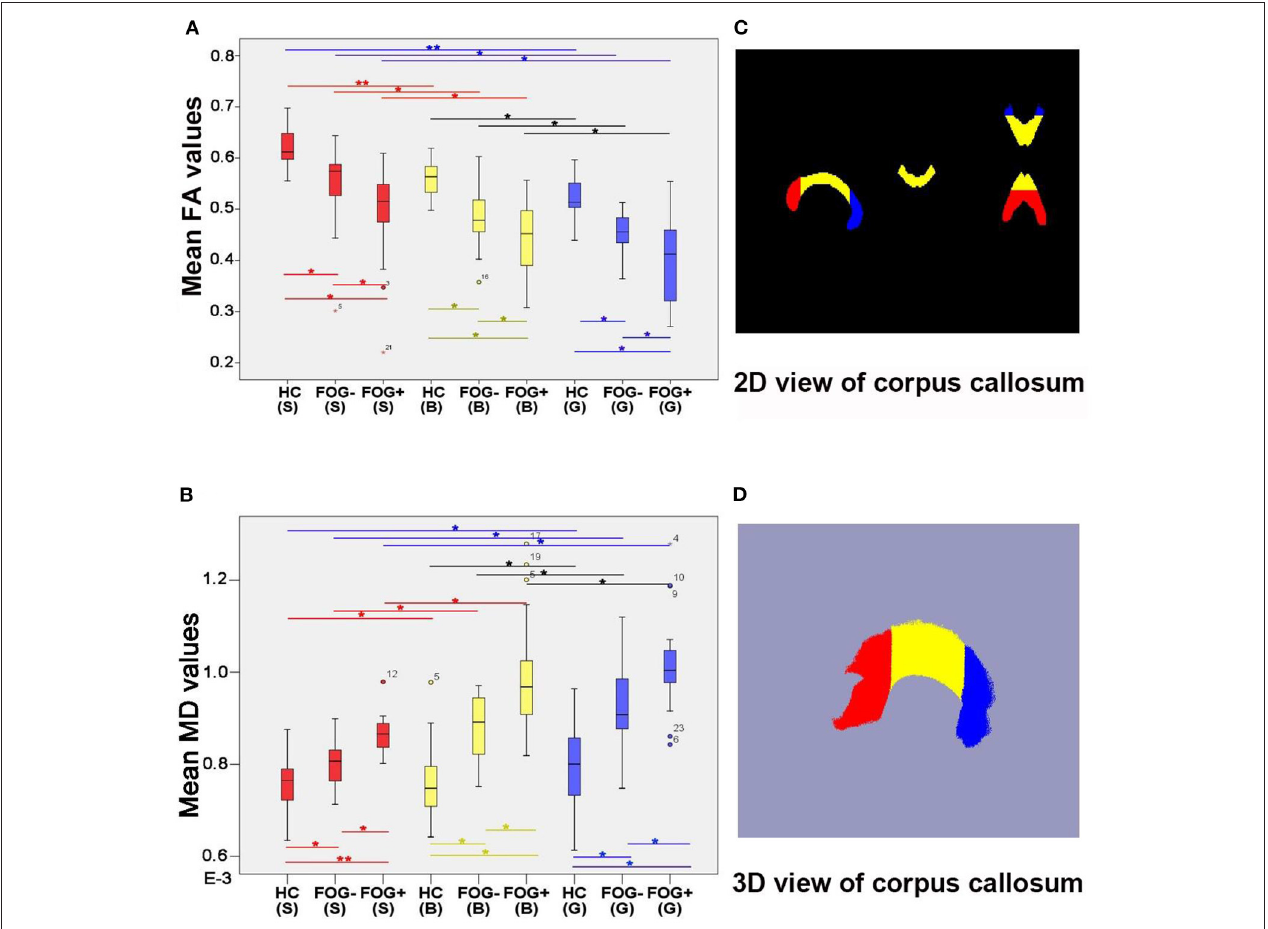
FIGURE 3 | Comparison of FA and MD values of CC splenium, body, and genu. (A) Comparison of FA values. (B) Comparison of MD values. (C) 2D view of CC. (D) 3D view of CC. * P < 0.05, ** P < 0.01 (two-sample t -test; FDR correction was applied to multiple comparisons). B, body; G, genu; S, splenium.